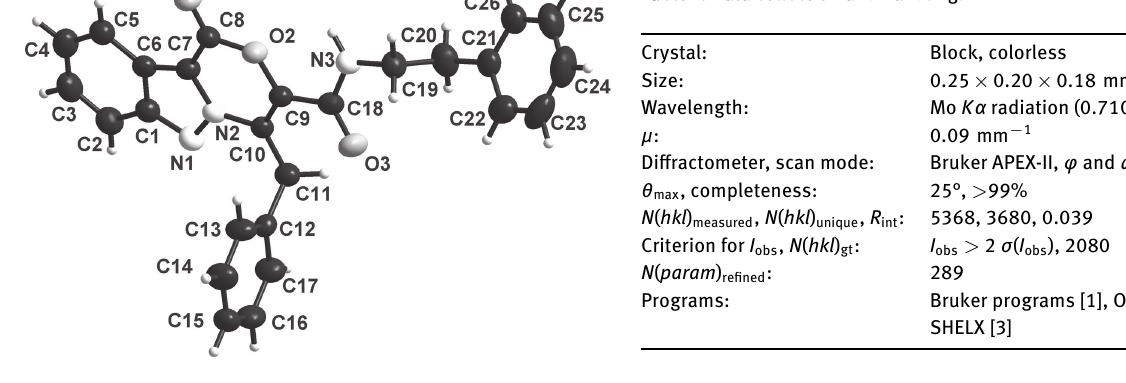
Table 1: Data collection and handling.